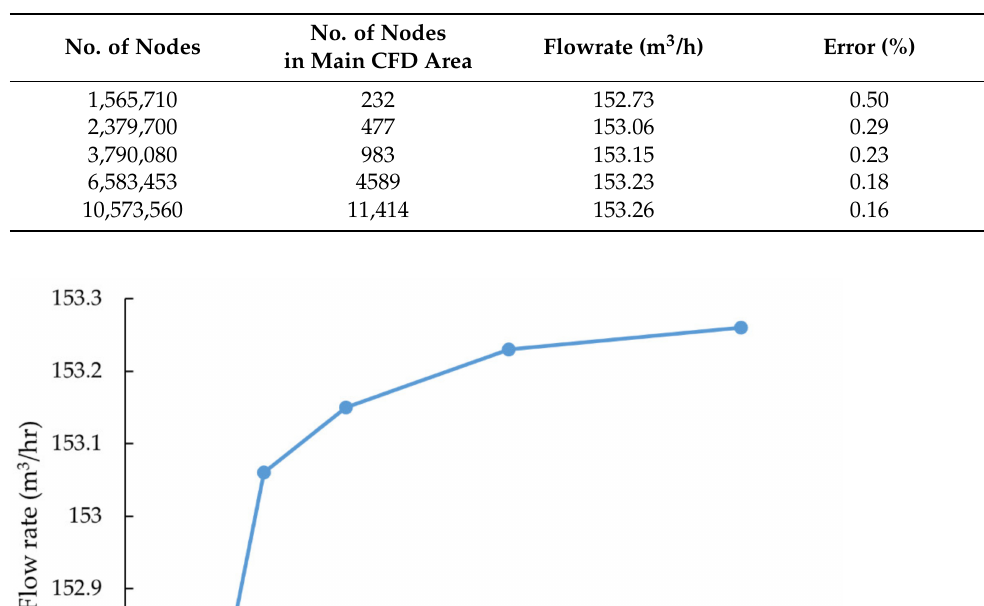
Table 3. Mesh sensitivity study for CFD.